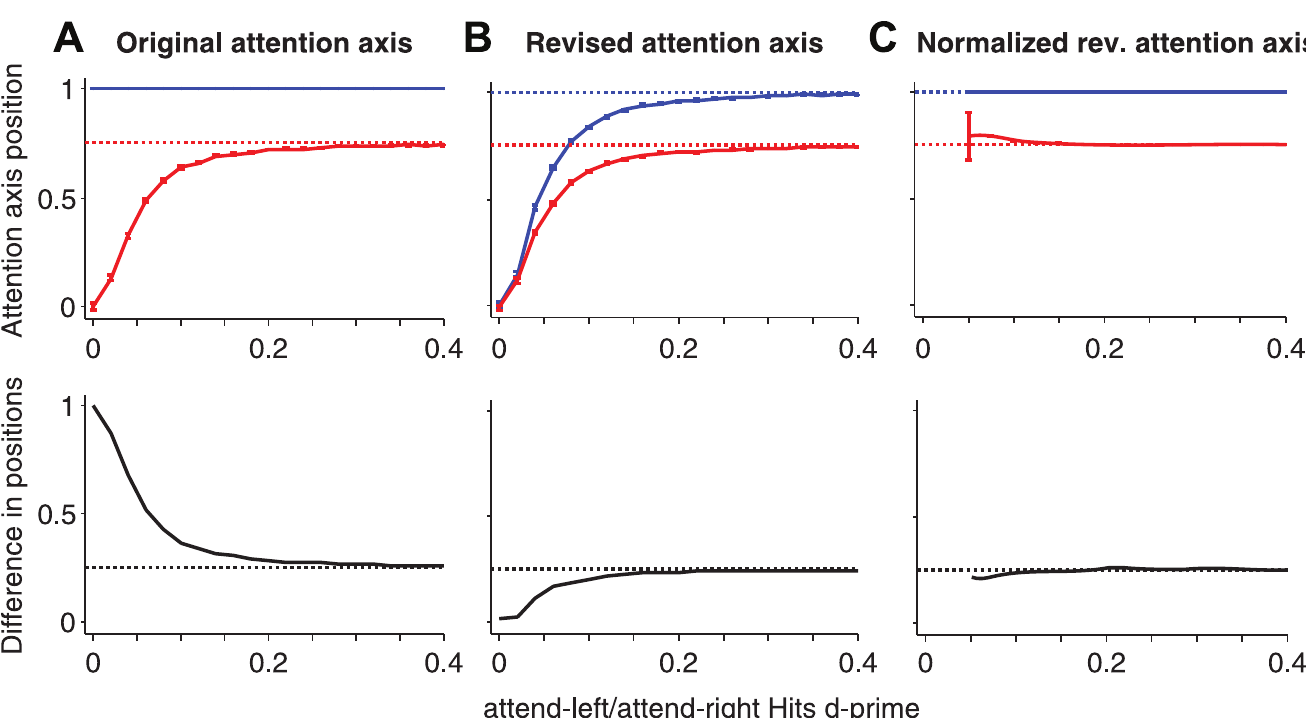
Fig 3. Average Hit (blue) and Miss (red) positions on the original (A), revised (B), and normalized revised (C) attention axes for attend-right responses only. Correct values are indicated by dotted lines. The original attention axis (A) overestimates differences (black, bottom) between Hits and Misses when modulation by attention is weak. The refined attention axis (B) underestimates the true separation of 0.25 (dotted line) when modulation by attention is weak. (C) Re-normalizing the revised attention axis makes it easier to estimate Hit-Miss differences at modulations greater than a d' of ~0.1. Error bars (top row) are standard error and usually less than the thickness of the line itself.